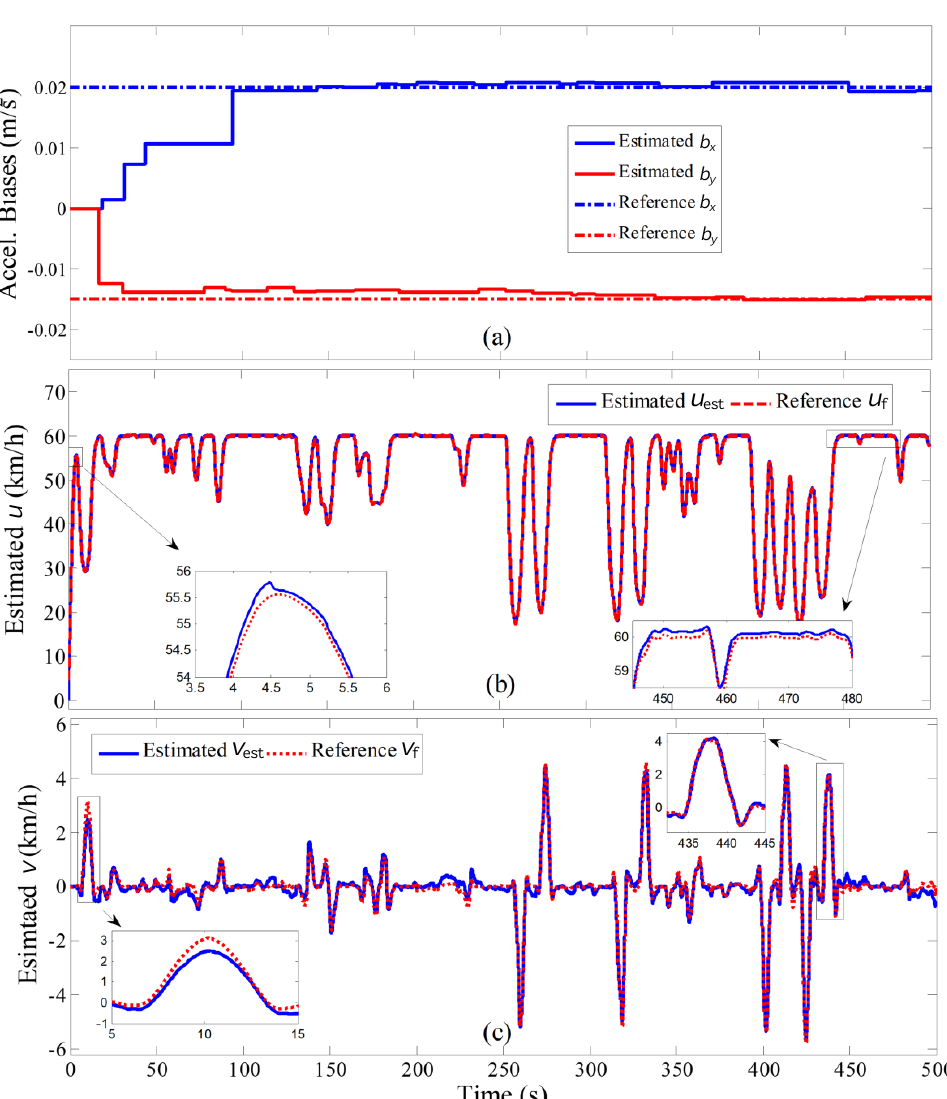
Figure 15. The estimation results of the mountain-road test: ( a ) acceleration biases ( b ) longitudinal velocity; ( c ) lateral velocity.